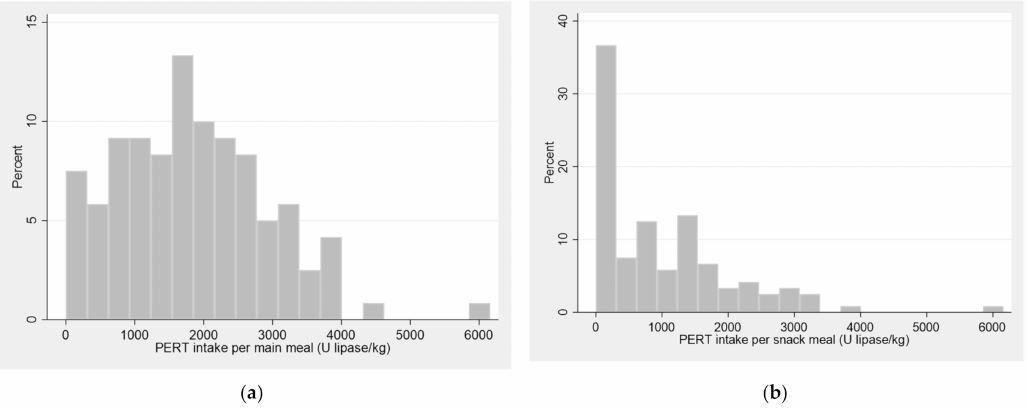
Figure 1. Intake of pancreatic enzyme replacement therapy for ( a ) main meals and ( b ) snack meals. In addition, the PERT dose was associated with GI symptoms. Participants with constipation for one or more days/month used 615 (95% CI: 228; 1002) U lipase/kg less than participants who never experienced constipation. Mild/severe constipation and diarrhoea were both associated with marginally lower PERT doses than those reporting normal stool consistency: − 541 (95% CI: − 1088; 6) U lipase/kg and − 407 (95% CI: − 816; 2) U lipase/kg, respectively. Abdominal pain was not associated with PERT dose. Seven participants were lung transplanted. Their PERT dose was 1206 (95% CI: 490; 1921) U lipase/kg higher than that of other participants. Furthermore, CF-related diabetes was associated with a marginally higher PERT dose: 370 (95% CI: − 8; 748) U lipase/kg. We did not find that PERT use for main meals was associated with CF-related liver